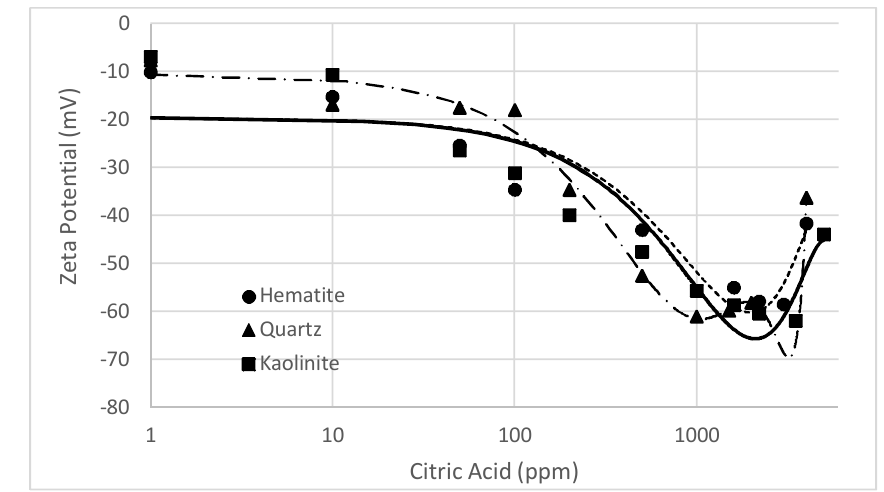
Fig. 7: Effect of Ca on the ZP of Hematite, Quartz and Kaolinite at 10.5